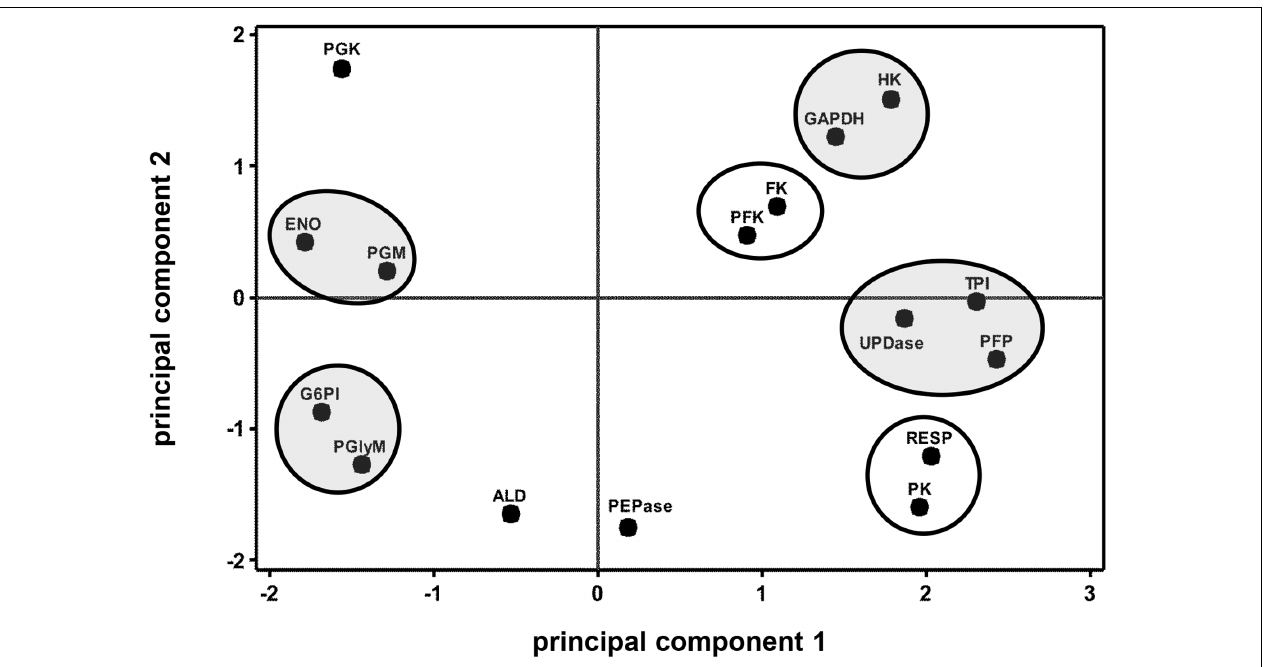
FIGURE 3 | Principal component analysis (PCA) score plot of the changes in glycolytic enzyme activities and respiration rate (RESP) during 60 days storage. Ovals identify groups of metabolites that exhibit similarities in storage-related concentration changes. Ovals are gray where metabolites share similar changes in concentration, but have no obvious connection with each other. Roots were stored 10 days at 10 ◦ C and 90 ± 5% RH, then stored at 4 ◦ C, 90 ± 5% RH for an additional 50 days. Principal components 1 and 2 account for 41 and 21%, respectively, of the variance in the data after standardization. Abbreviations used for enzymes are defined in Table 1 . PCA loading plot is available in Supplementary Figure